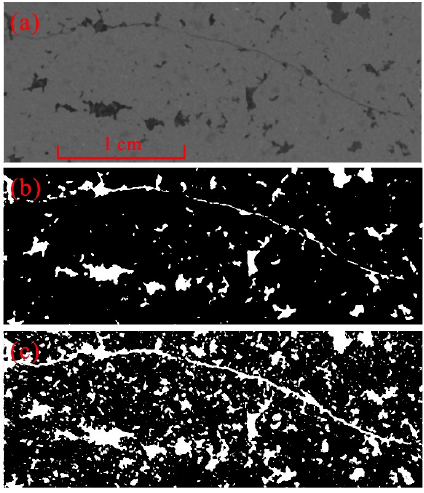
Figure 2. Binary threshold image segmentation: ( a ) the original figure, ( b ) the segmented image using a low threshold, and ( c ) the segmented image using a high threshold. The fractures cannot be segmented as shown in the subgraph ( b ) and the volumes of the pores and the vugs spilled out in the subgraph ( c ).